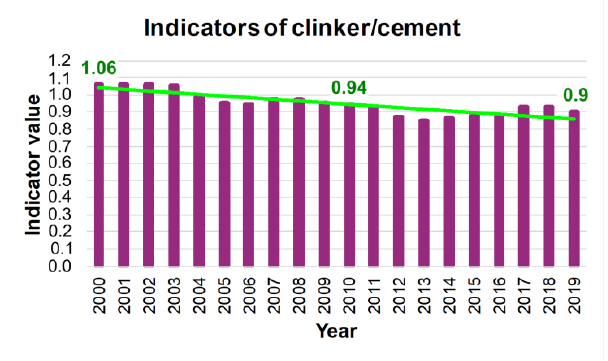
Figure 3. Changes in the clinker/cement index at the beginning of the 21st century.